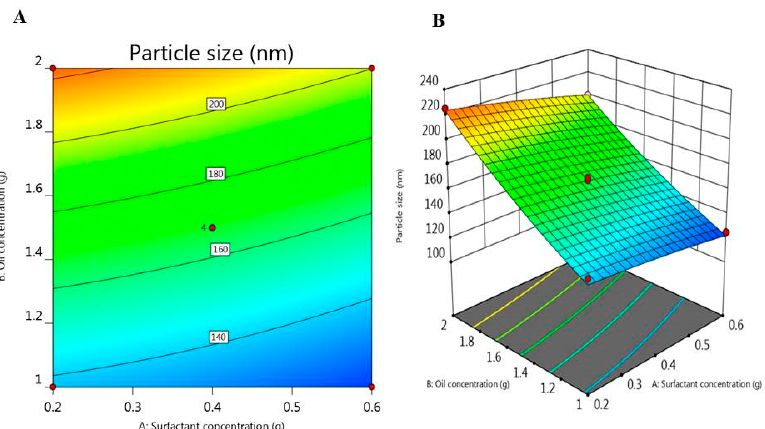
Figure 2. ( A ) 2D ‐ Contour plot and ( B ) 3D ‐ response surface plot representing the influence of sur ‐ Figure 2. ( A ) 2D-Contour plot and ( B ) 3D-response surface plot representing the influence of factant concentration (g) and oil concentration (g) on particle size (nm). surfactant concentration (g) and oil concentration (g) on particle size